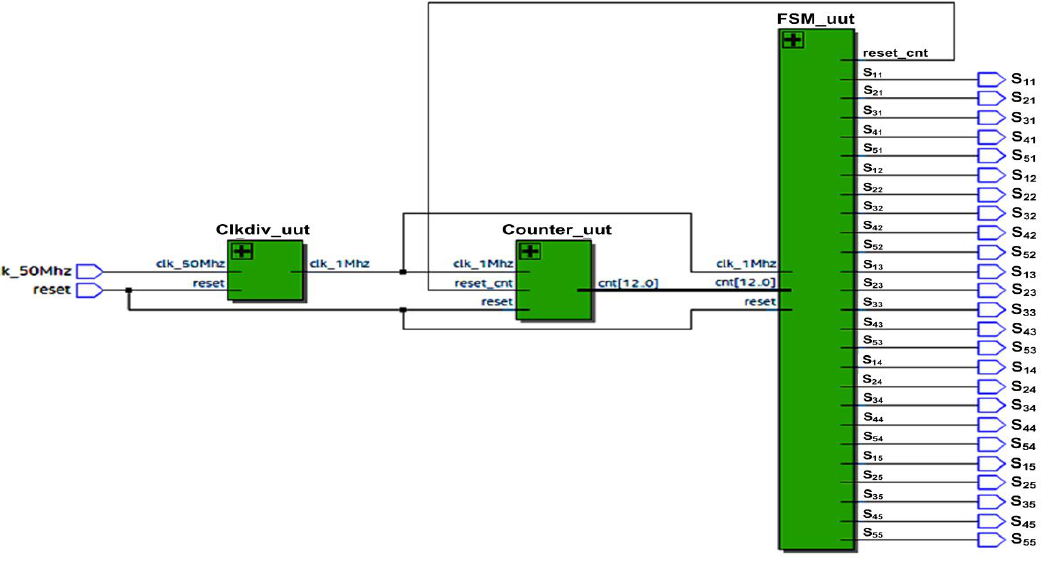
Figure 14. Schematics of the synthesised SHE digital switching controller using the Intel FPGA (Cyclone IV E) chip.